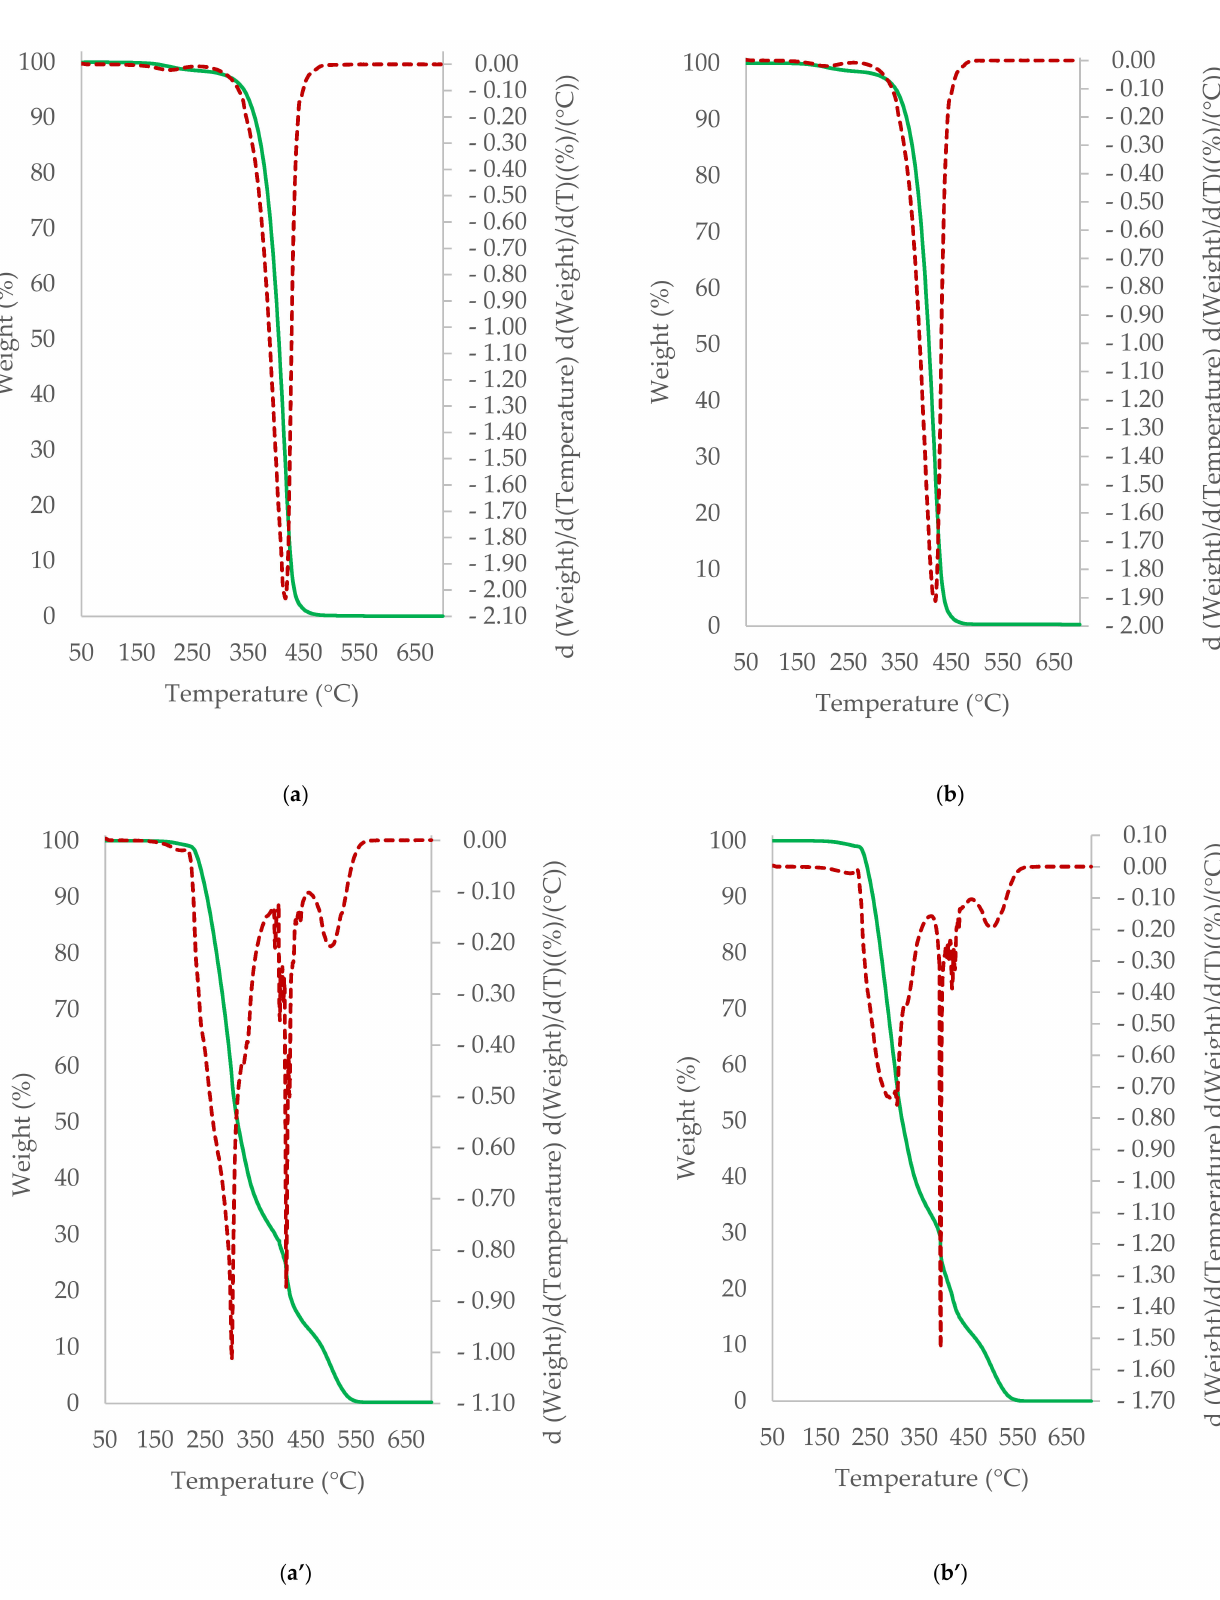
Figure 5. TGA and DTG curves of fats extracted from cocoa beans Criollo (Peru), unroasted ( a ) in nitrogen ( a’ ) in oxygen and roasted ( b ) in nitrogen and ( b’ ) in